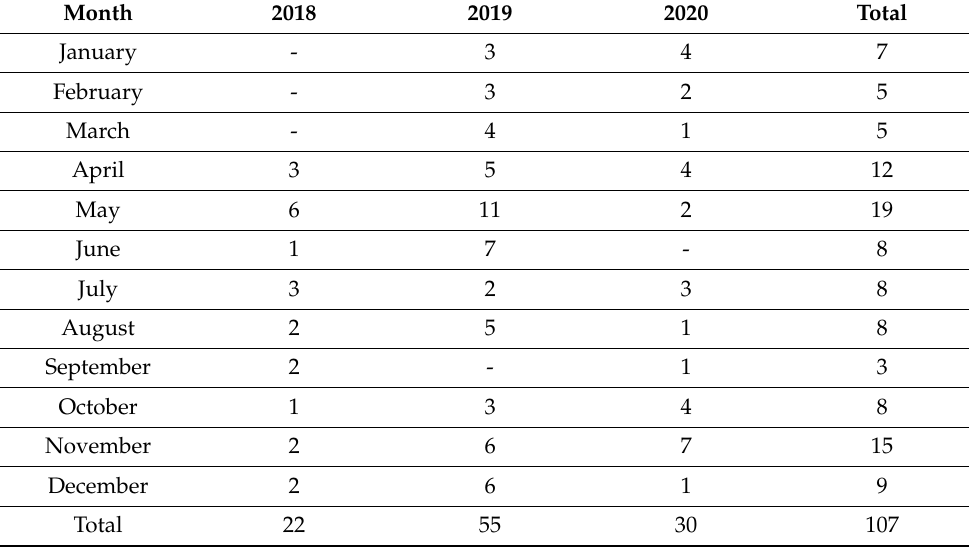
Table 1. The number of gazelle carcasses (samples) collected along the study period, by months and years. For three carcasses out of the total 110 collected, we did not have records of month, year, or both.